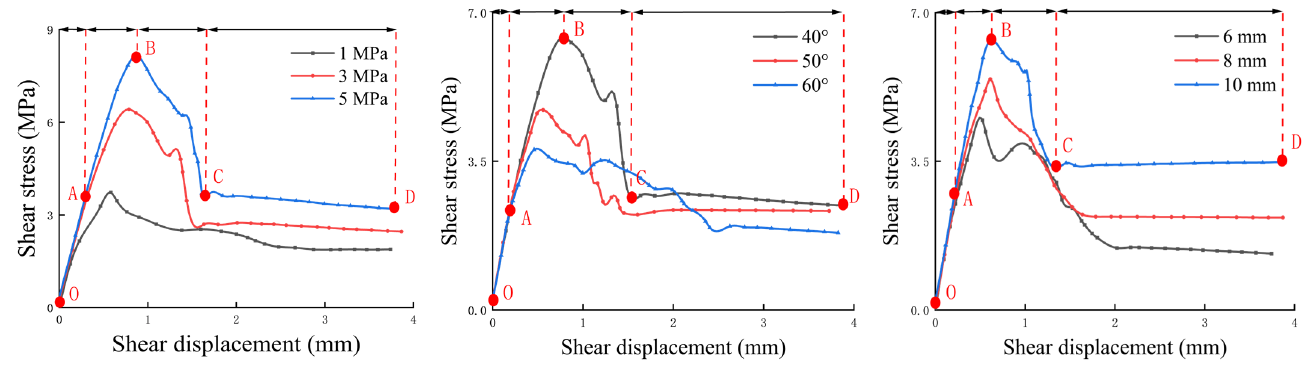
Figure 5. Shear displacement–shear stress curve of rock discontinuity.